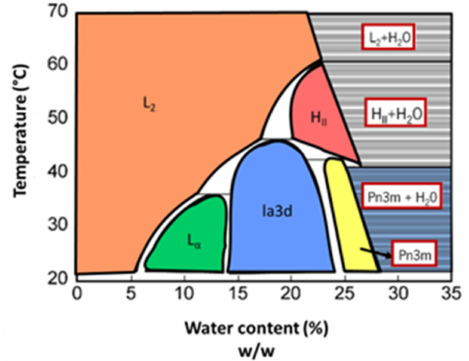
Figure 8. Phase diagram of the phytantriol–water system. L c and L ∝ represent the lamellar phases (crystalline and fluid, respectively). Ia3d and Pn3m are the inverted bicontinuous cubic phases. L 2 and H II correspond to the inverted micellar and hexagonal phase, respectively. Adapted from Barauskas and Landh, 2003